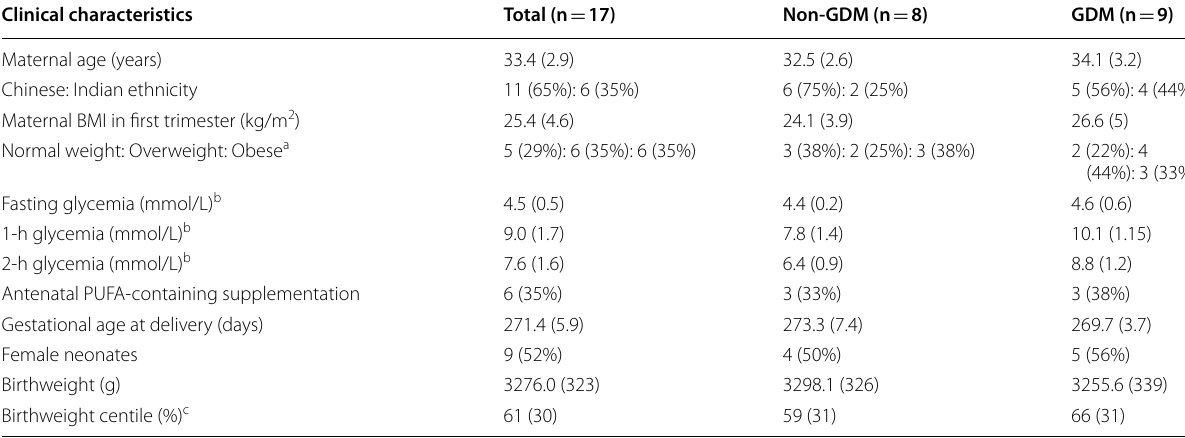
Data presented as Mean (SD) or n (%) a WHO recommended Asian-specific BMI cut-off that is associated with increased metabolic risk (WHO EC 2004): Normal 18.5–22.9 kg/m 2 , Overweight 23–27.4 kg/m 2 ,